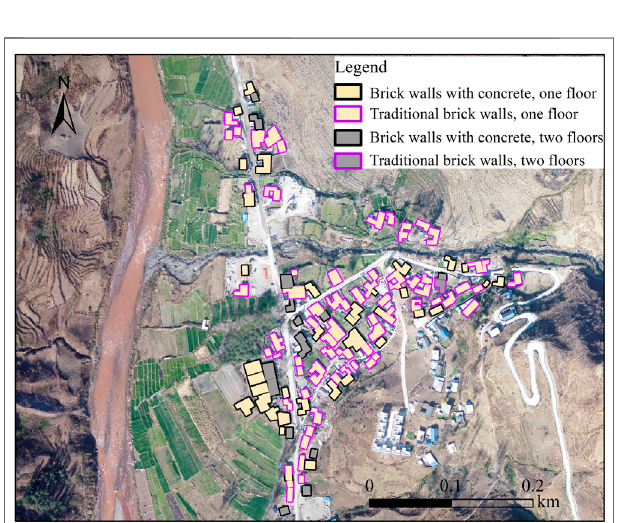
FIGURE 3 | Run-out zone for a debris fl ow with a recurrence interval of 50 years in Niunaidu Gully.